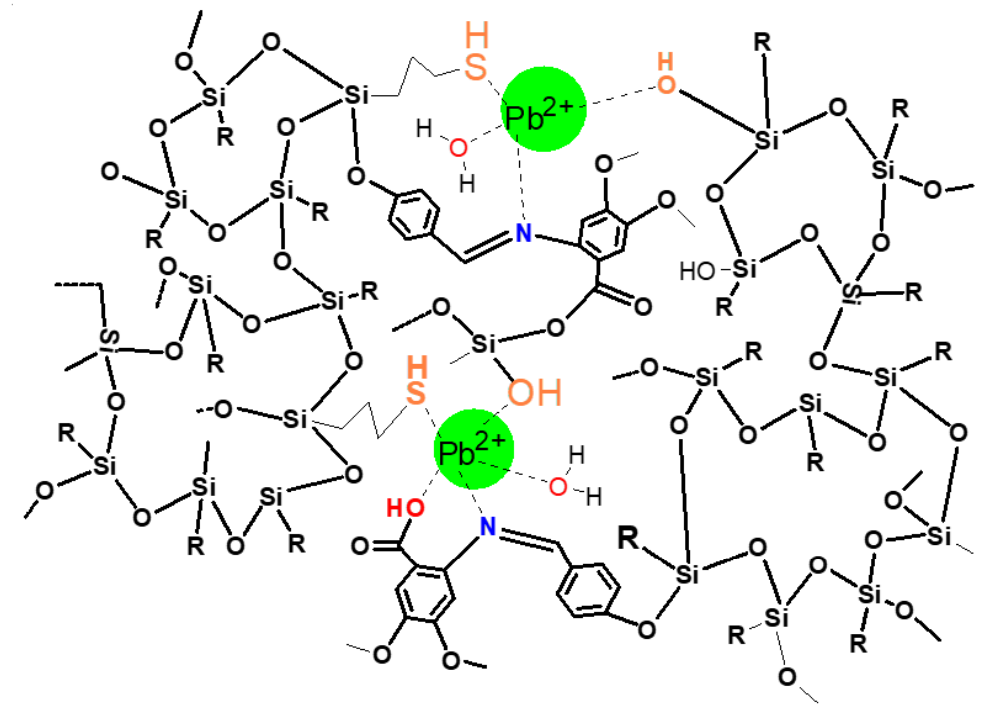
Figure 20. Pb(II) ion adsorbent 1 complex formation.